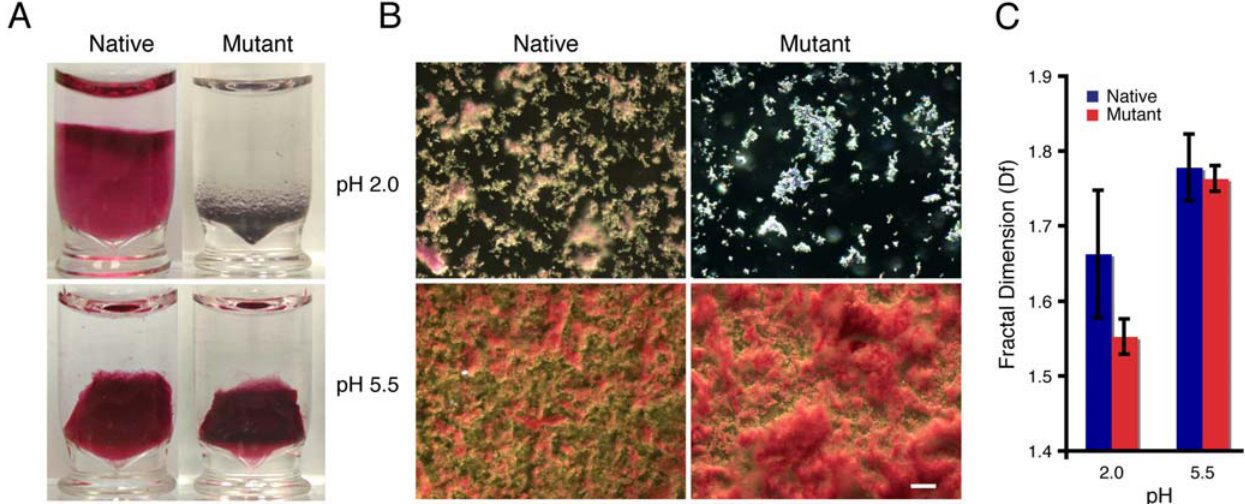
Figure 3. Effect of pH in the formation and structure of hydrogels assembled with native or mutant phage. (A) Vials with hydrogels prepared with native and mutant phage at pH 2.0 (top) and 5.5 (bottom). Au NP of 50 6 8 nm were prepared by citrate reduction. (B) Darkfield micrographs (elastic scattering) of hydrogels in (A) (constant light intensity). (Scale bar, 10 m m). (C) Df of structures in (B) determined with box counting Df analysis (ImageJ